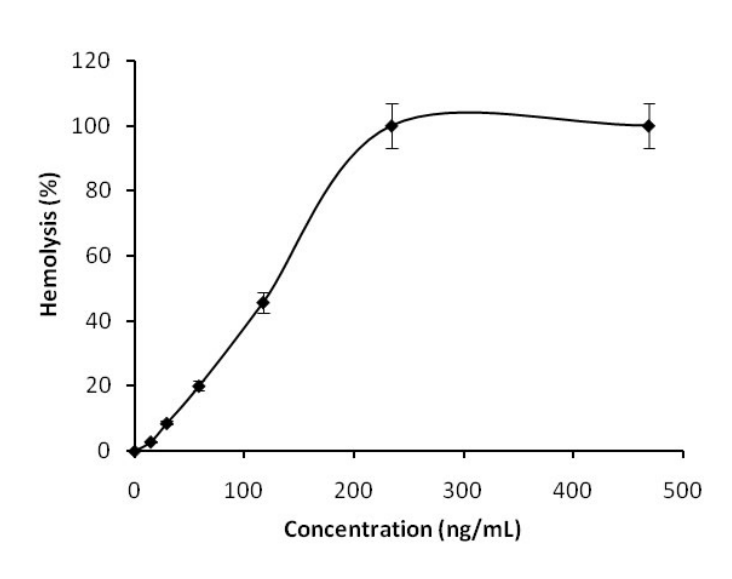
Figure 2. Titration of hemolytic activity. Hemolysis was measured turbidimetrically at room temperature using a microplate reader. The hemolysis percentage was calculated as described in “Materials and Methods”. Data points shown are means of three independent experiments